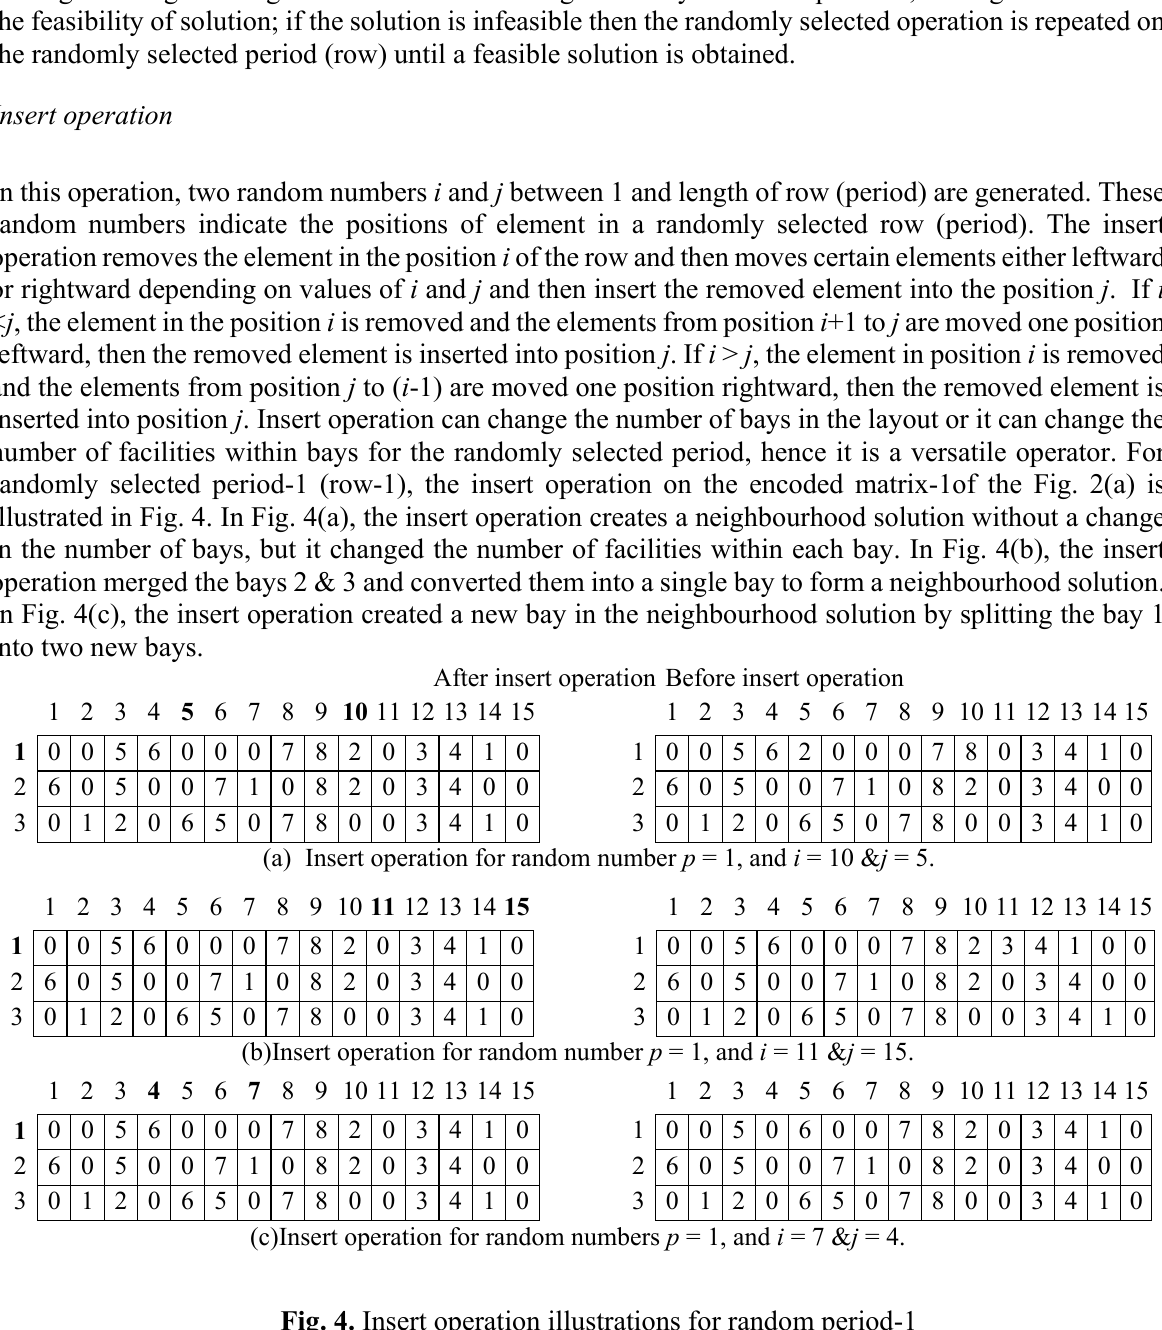
Fig. 4. Insert operation illustrations for random